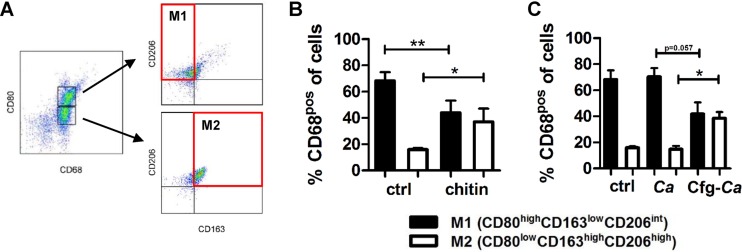
Purified fungal chitin and increased cell wall chitin exposure of C. albicans changes macrophage polarization. (A) The gating strategy was that classically activated macrophages (M1) were defined as CD68pos CD80high CD163low CD206int (where “pos” is positive and “int” is intermediate) and alternatively activated macrophages (M2) as CD68pos CD80low CD163high CD206high. (B and C) IFN-γ/LPS-activated macrophages were stimulated with 10 µg/ml purified C. albicans chitin for 24 h (B) or with heat-inactivated C. albicans (with or without caspofungin treatment [Cfg]) (C), and the expression of CD80, CD163, and CD206 was determined by flow cytometry (n = 4; *, P < 0.05; **, P < 0.01). All data are presented as mean values ± SD.